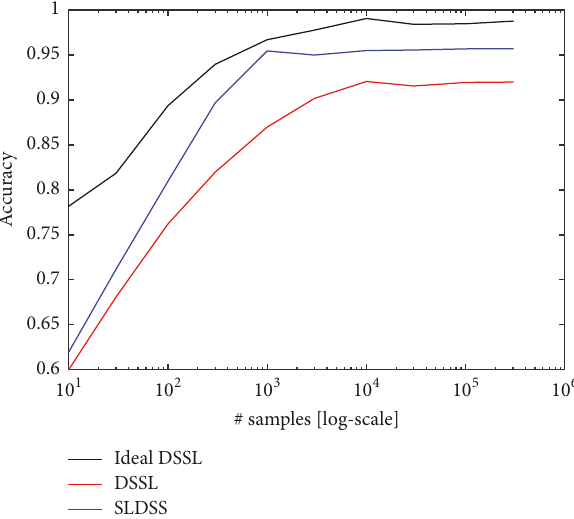
Figure 2: Synthetic experiment. Influence of the problem dimen- sionality (number of features) on the accuracy of ranking methods.